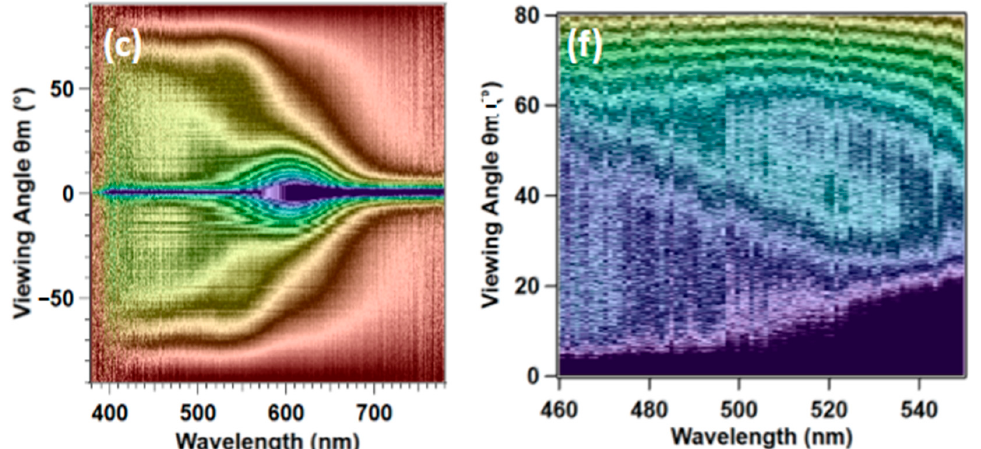
Figure 3. Hemispherical scans of relative reflectance on the z-axis for ( a ) 0, ( b ) 20, and ( c ) 40 BIOS pass polymer opals. The high-angle structural color reflectance hotspots are shown for these opals, respectively, in ( d – f ). Relative reflectance is seen to exceed 100% due to measurements being taken with reference to a Lambertian scatterer.